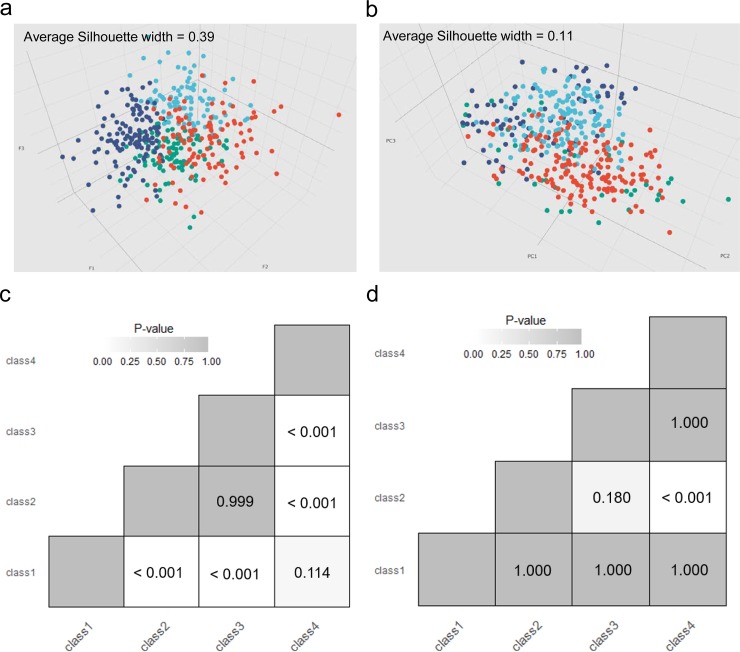
Benchmark of clustering performance in the gastric cancer subtyping case study.3D visualization revealed patient samples classified to different subtypes were much more tightly distributed in (a) the three-dimensional feature space based on ELM-CC clustering result (average Silhouette width = 0.39) than (b) in the space of top three principal components of gene expression profiles based on Consensus clustering result (average Silhouette width = 0.11). SigClust analysis showed more statistically significant (P < 0.05) pairwise comparisons of subtypes identified based on (c) ELM-CC than (d) the counterpart based on classical consensus clustering method.